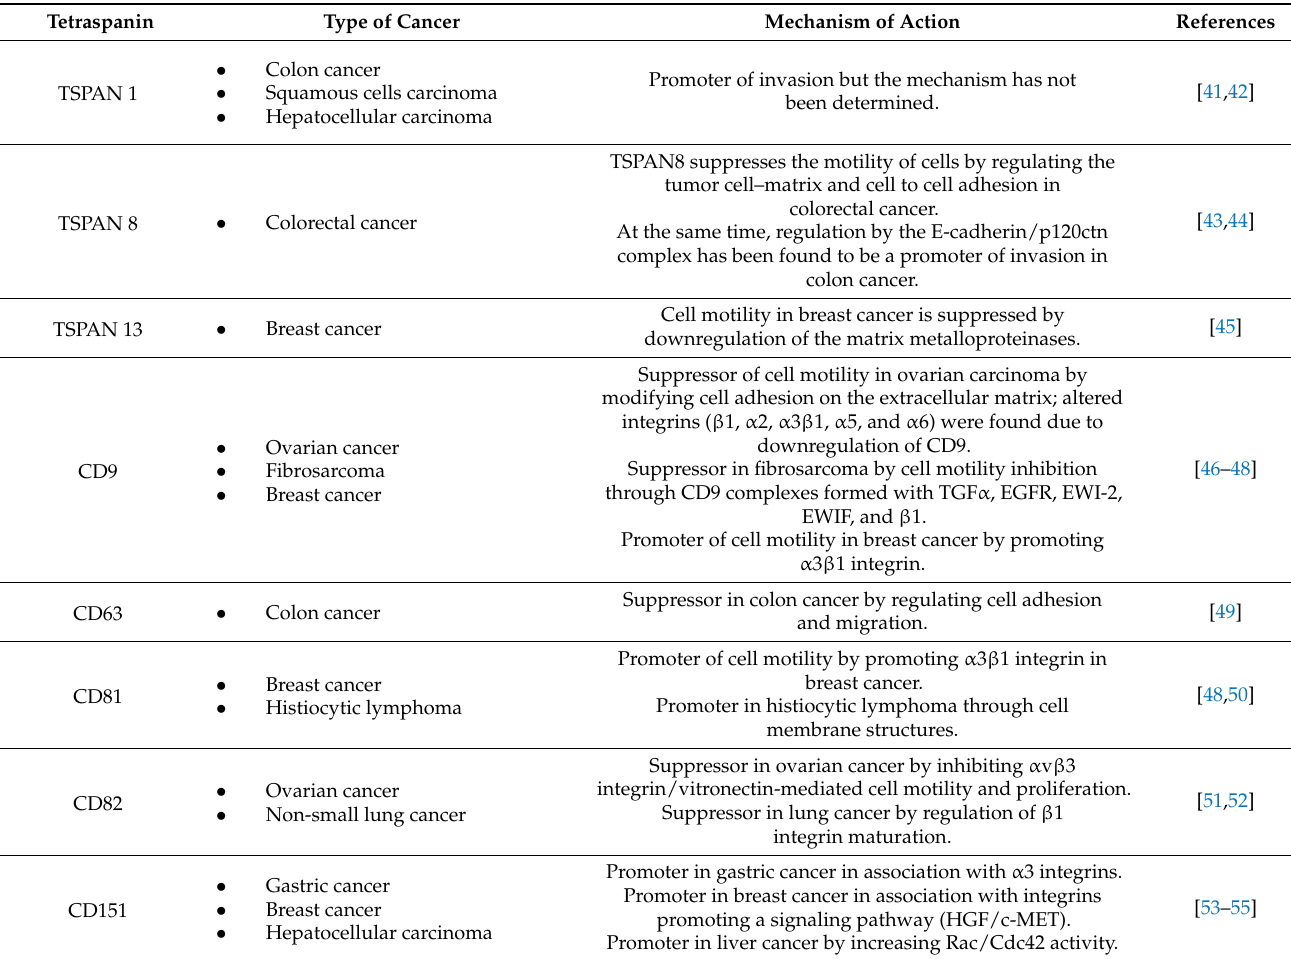
Table 1. Role of tetraspanins in